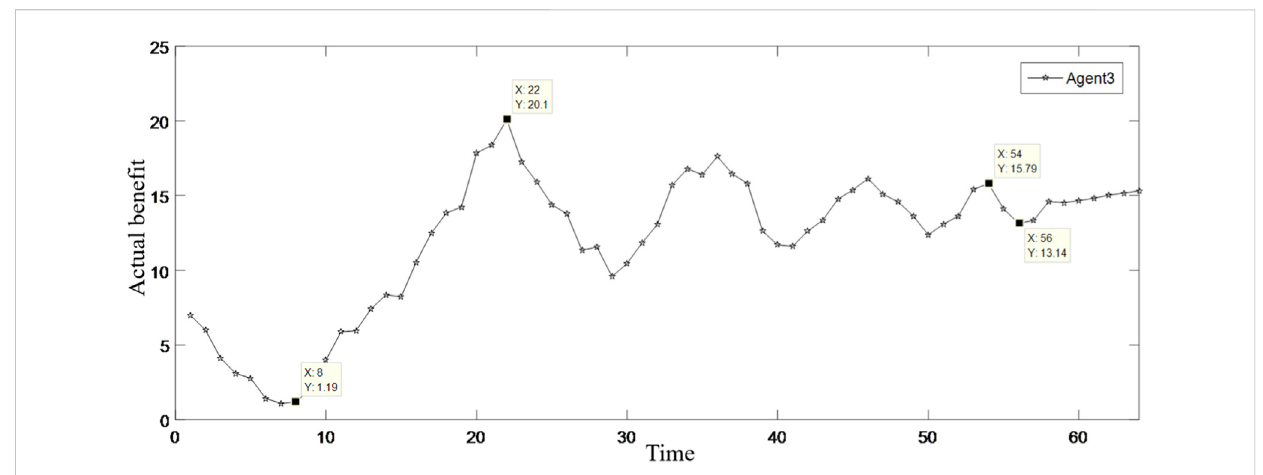
FIGURE 5 Changes in the bene fi ts of Agent 3.